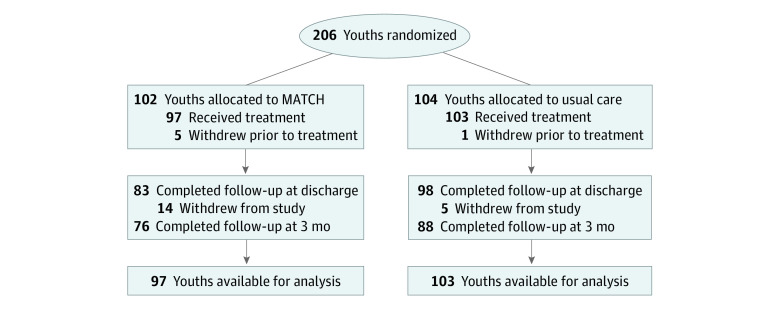
Flow Diagram of Youth ParticipantsMATCH indicates Modular Approach to Therapy for Children.